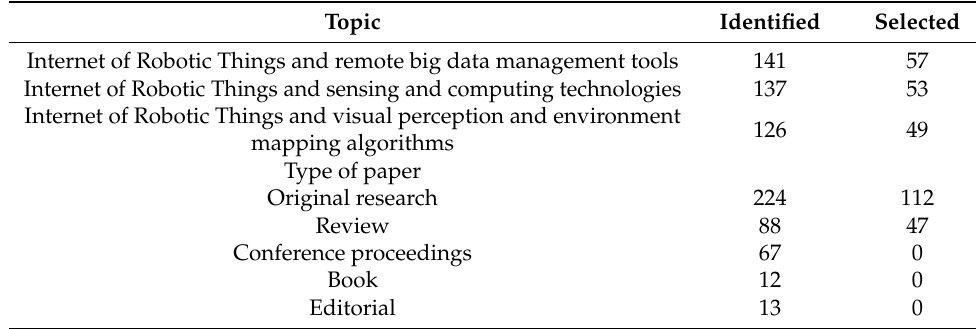
Table 1. Topics and types of identified and selected scientific products.